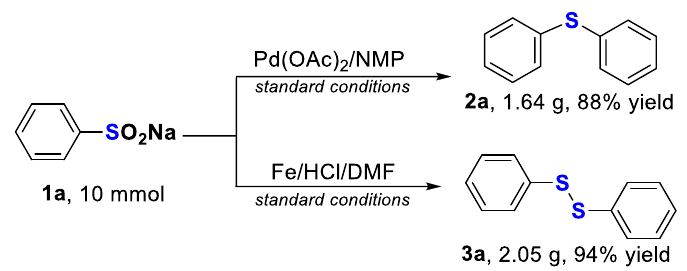
Table 3. Optimization of reaction conditions for sodium benzenesulfinate to diphenyldisulfide [a] .